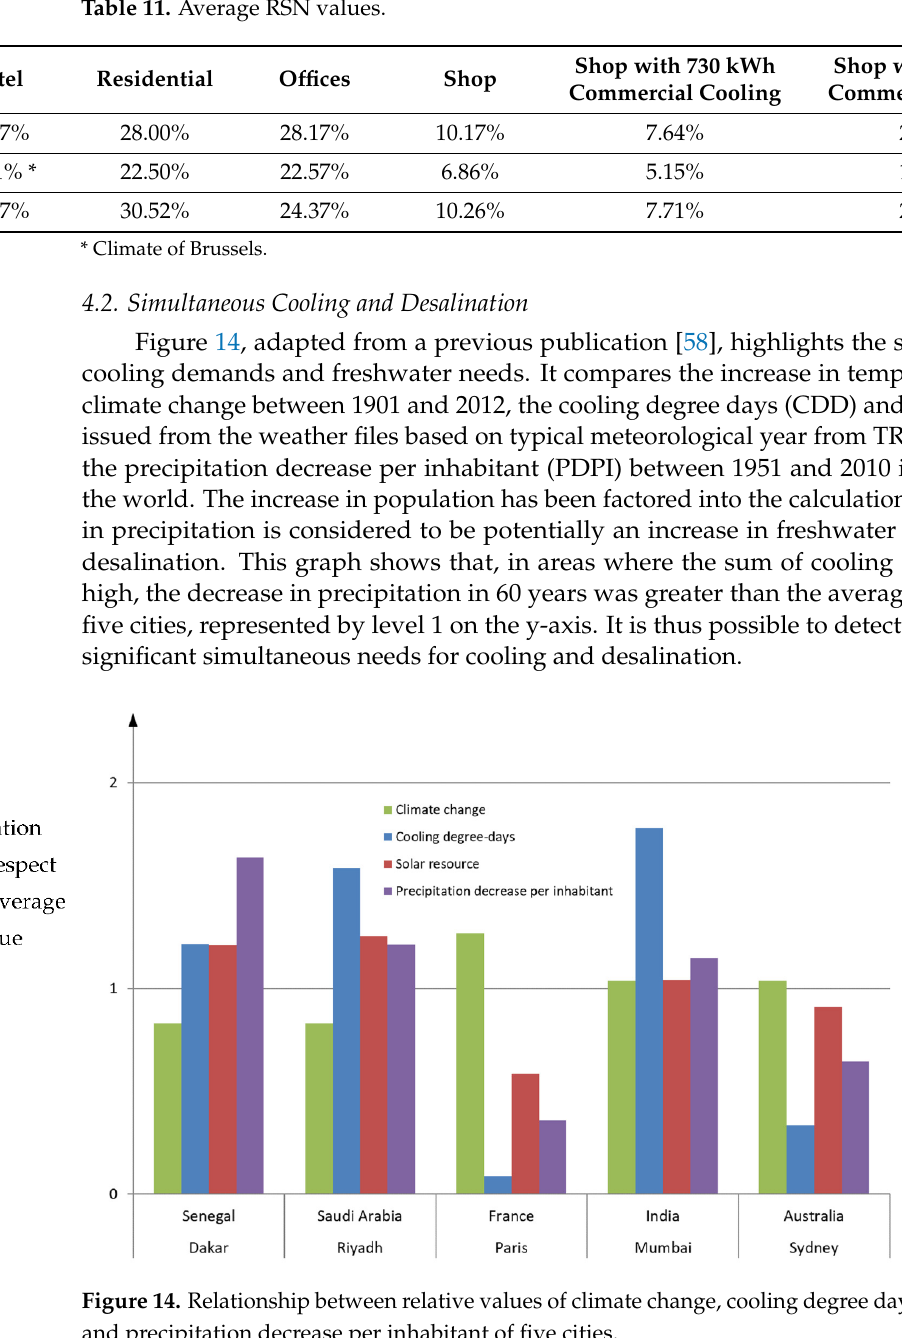
Table 11. Average RSN values.